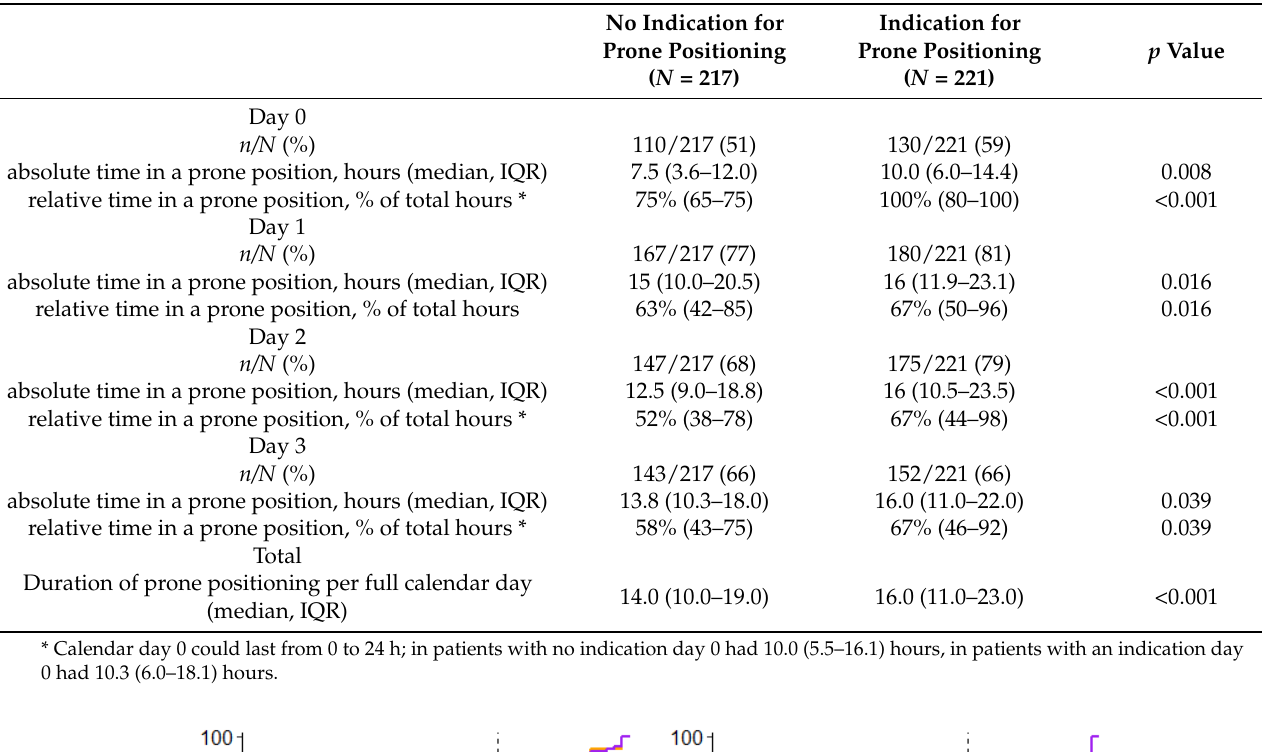
Table 2. Duration of Prone Positioning.